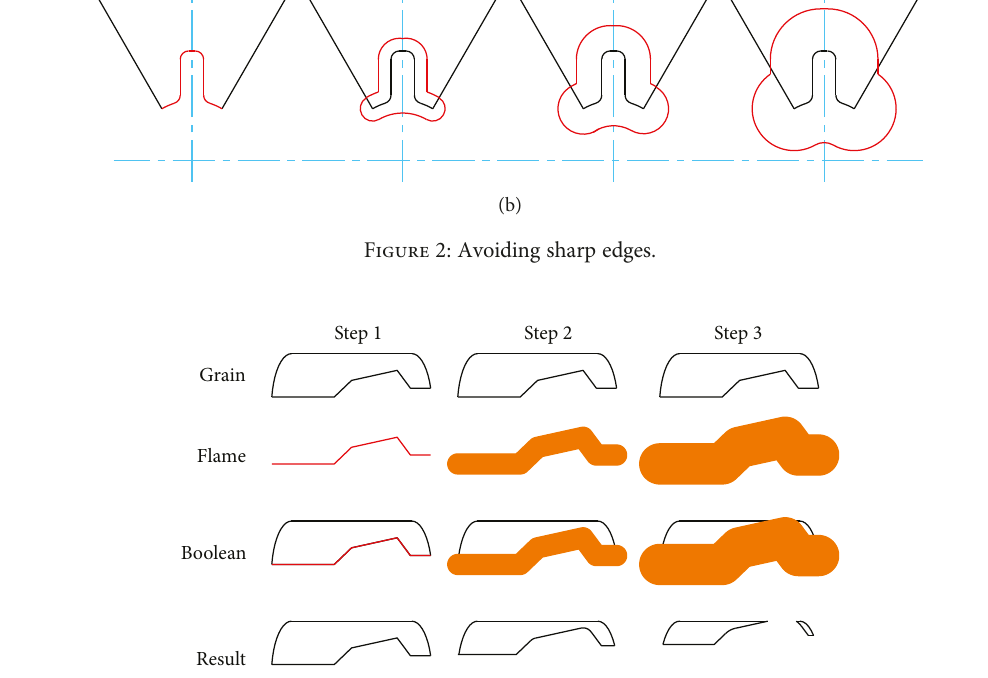
Figure 3: Boolean subtraction operation.